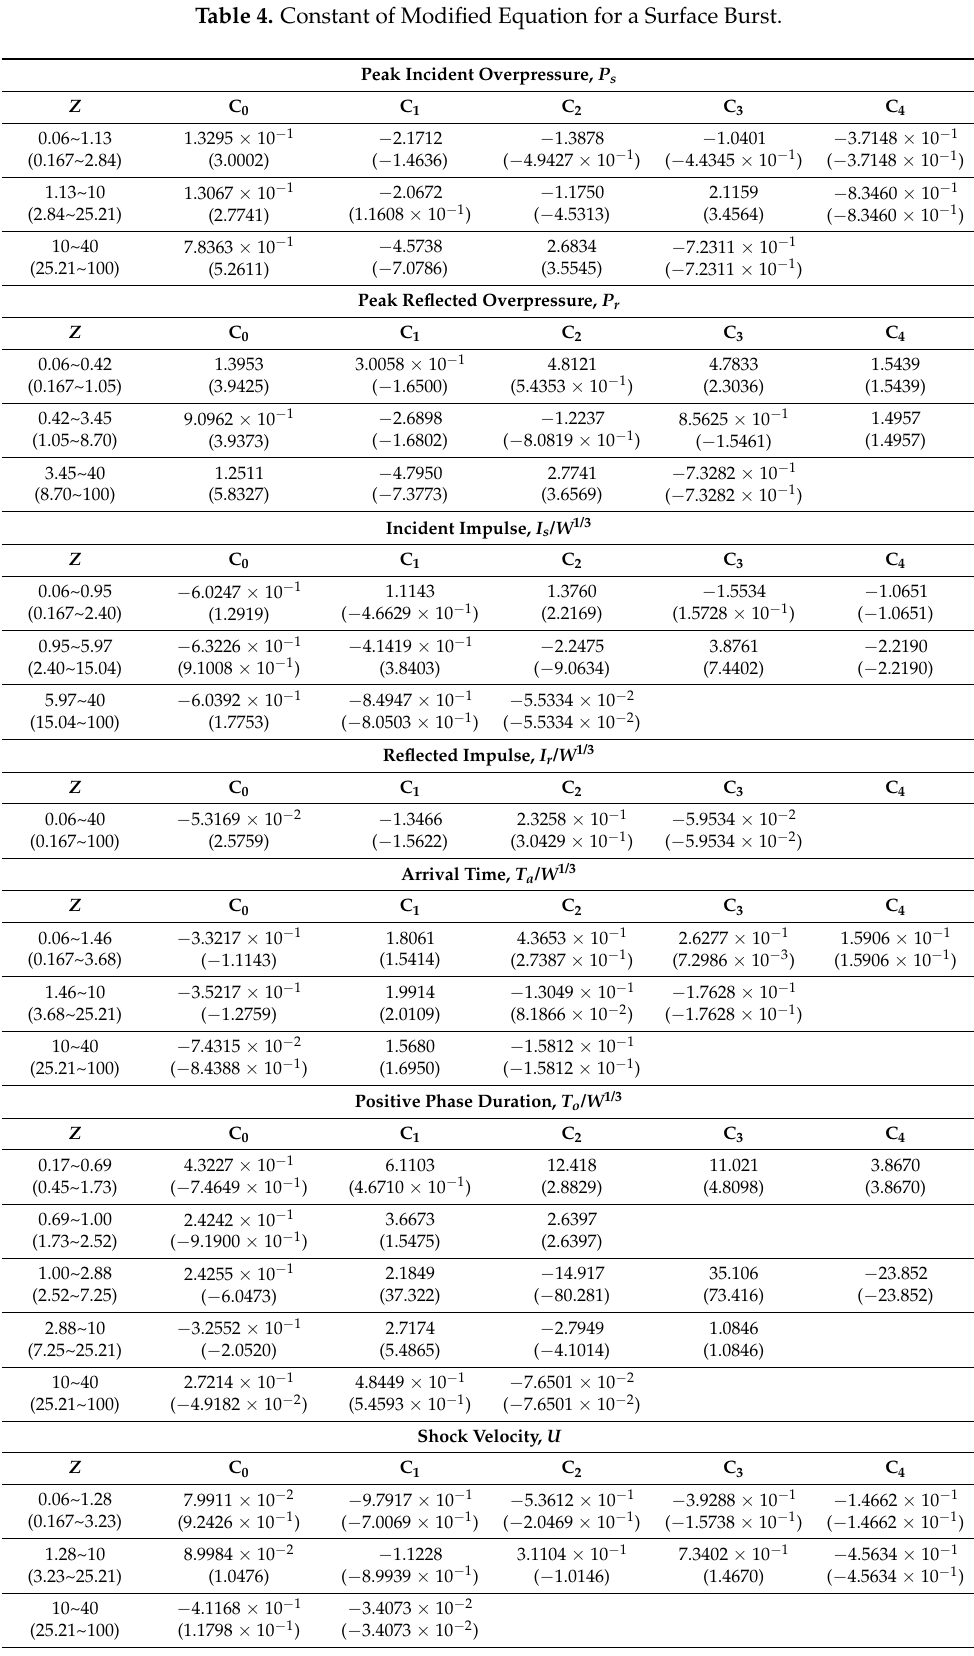
Table 4. Constant of Modified Equation for a Surface